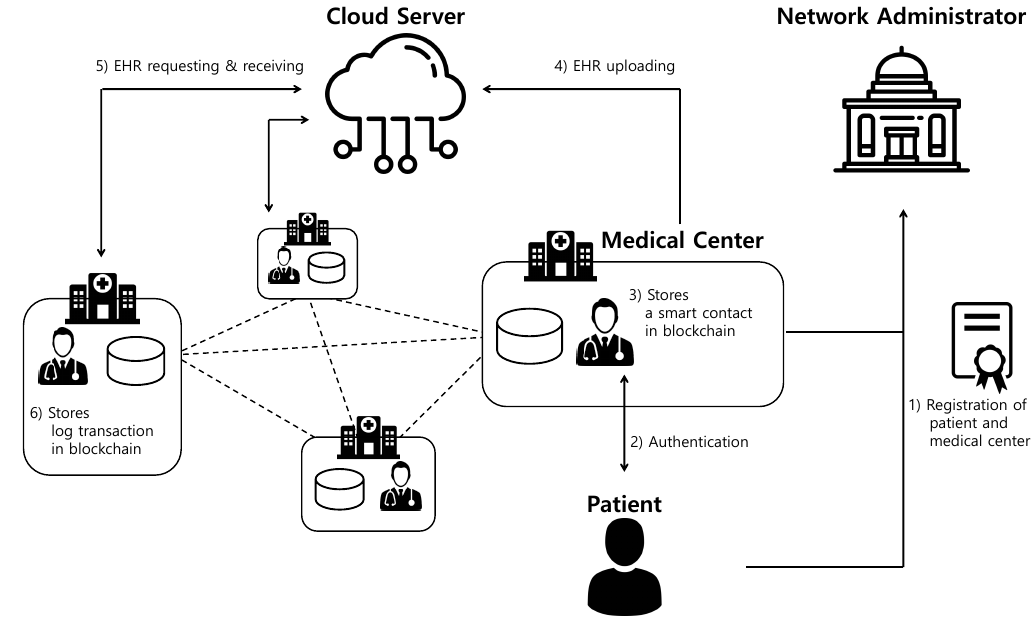
Figure 1. Proposed cloud-assisted electronic health record (EHR) system model using